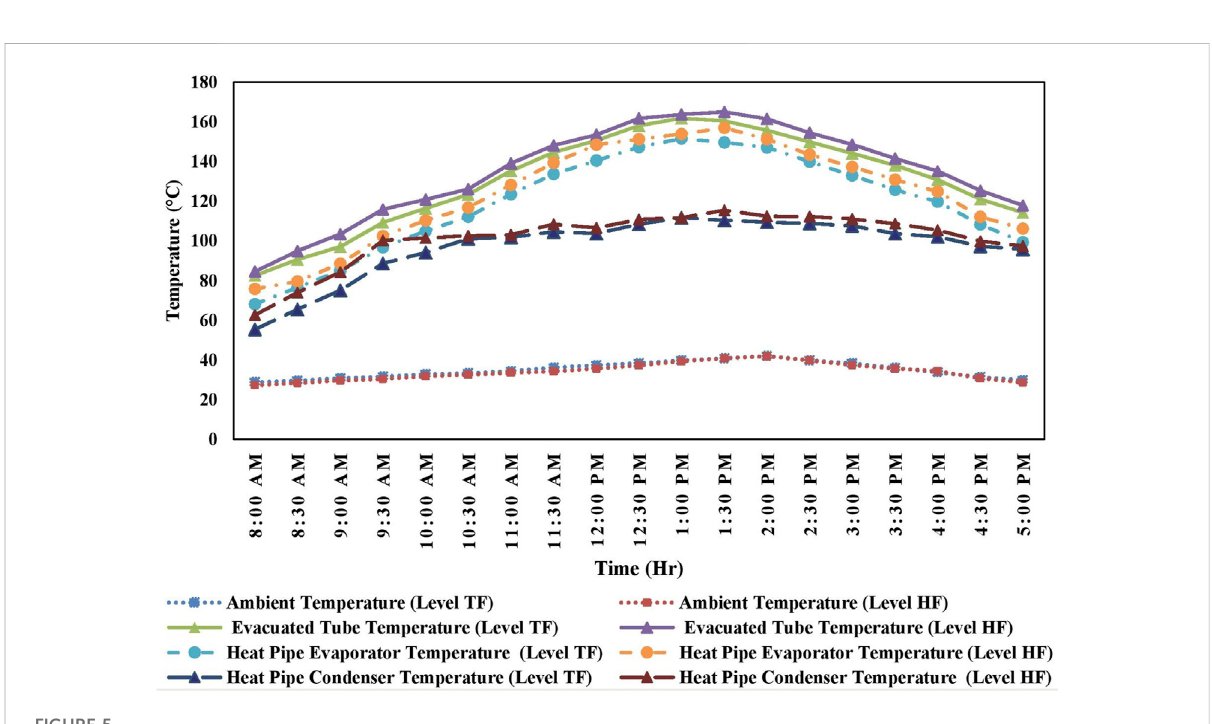
FIGURE 5 Temperature distribution pro fi le with